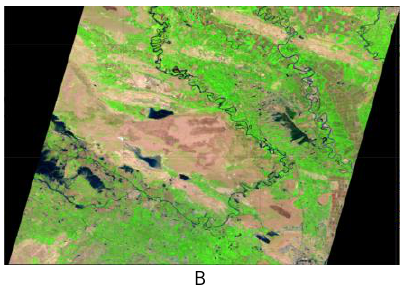
B Figure 1. Study area; A) Google Earth image, B) Sentinel 2.